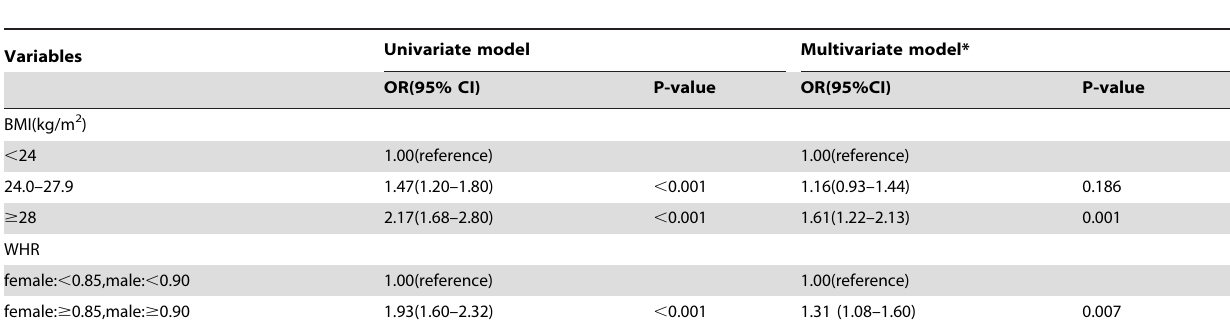
Table 2. Odd Ratios and 95% confidence intervals of elevated urinary albumin-to-creatinine ratio with